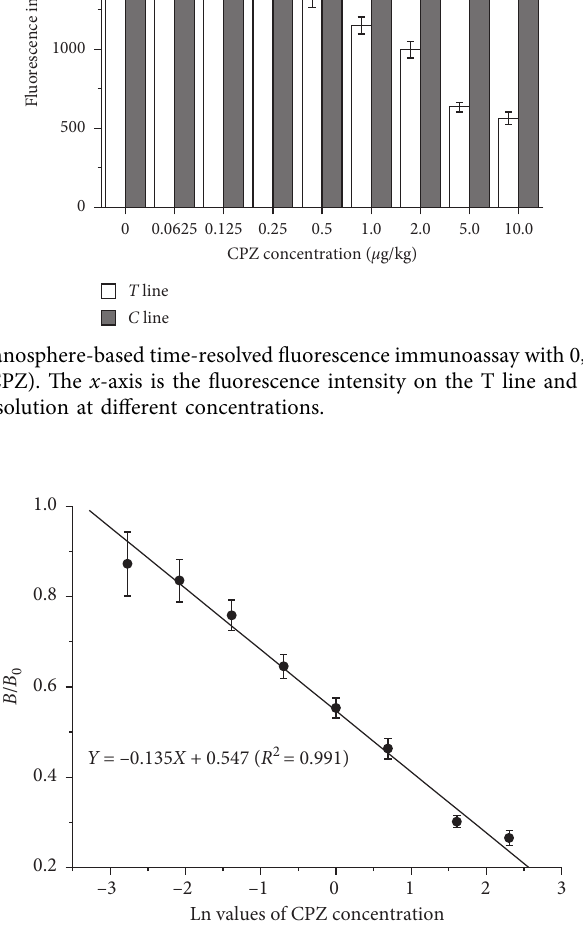
Figure 4: Standard curve of chlorpromazine (CPZ) detection via nanosphere-based time-resolved fluorescence immunoassay (eight levels of serial dilution containing 0.0625, 0.125, 0.25, 0.5, 1.0, 2.0, 5.0, and 10.0 μ g/kg of CPZ were prepared in PBS). The x -axis is the Ln value of CPZ concentration; the y -axis is the B / B 0 ratio of standard solution at each